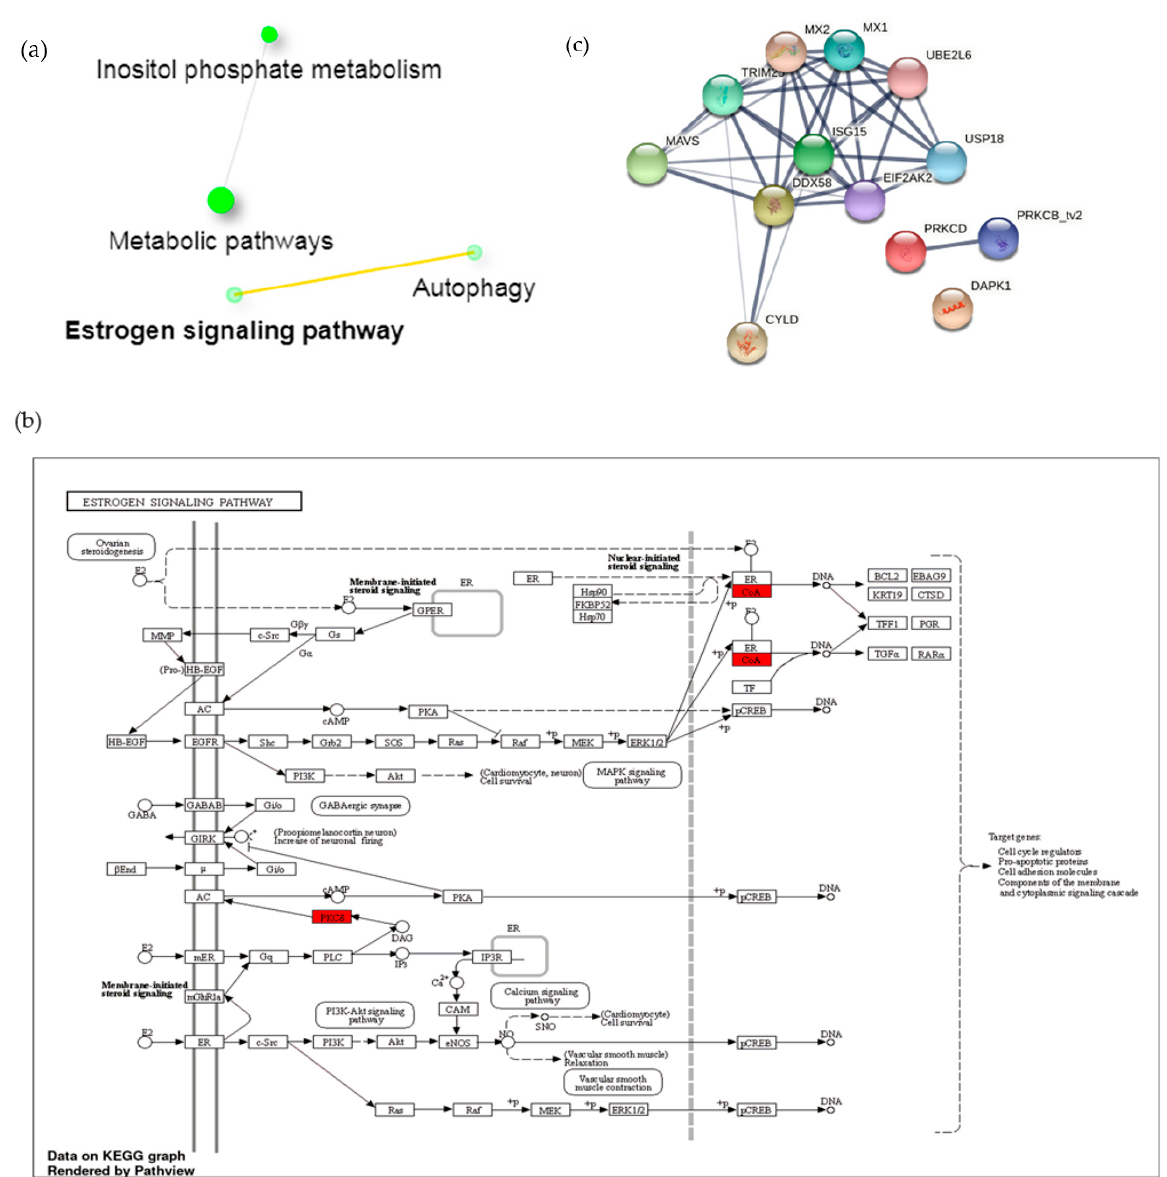
Figure 5. Network displaying the predicted interaction of signaling pathways and cytokine-related genes affected by suppression of anti-inflammatory genes. ( a ) Relationship between enriched pathways enhanced by down-regulated genes in A1-challenged. Nodes represent each pathway; two nodes are connected if they share 20% or more genes. Darker nodes are more significantly enriched gene sets. Bigger nodes indicate larger gene sets. Thicker edges represent more overlapped genes. ( b ) Estrogen signaling pathways and ( c ) protein-protein interactions showing predicted interactions between proteins encoded by down-regulated differentially expressed genes. Nodes with different colors represent different enriched proteins. Filled nodes indicate that a 3D structure is predicted. Edges represent protein-protein association or contribute a shared